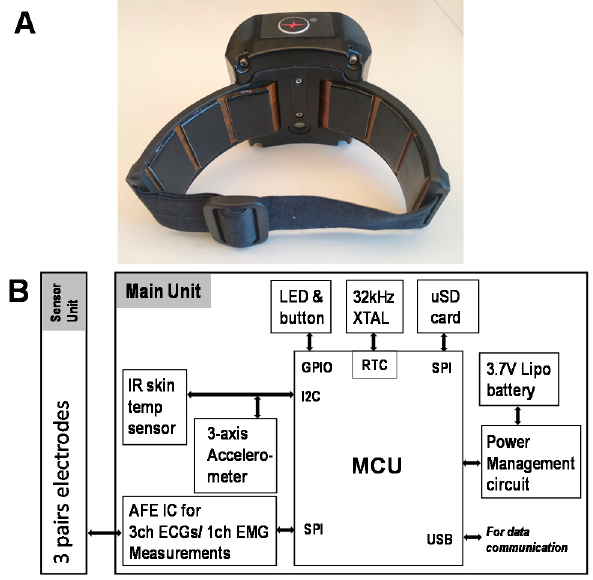
Figure 1. ( A ) Armband. ( B ) Schematic diagram of the armband.